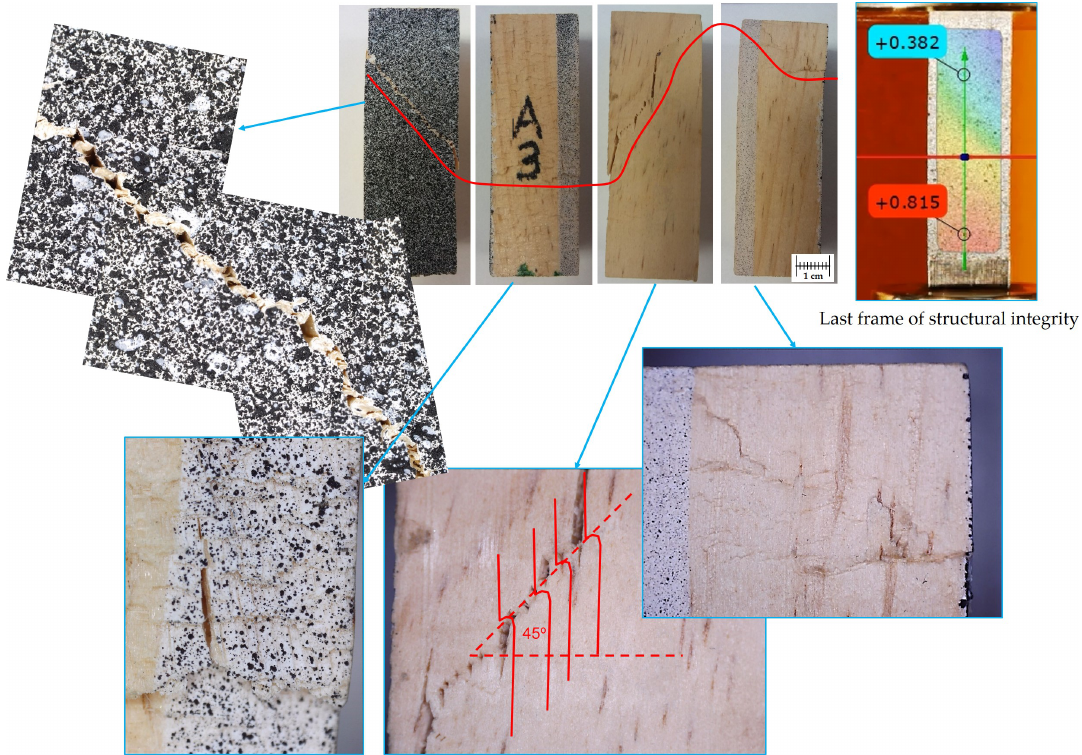
Figure 19. Appearance of the damage produced in the specimen A3. Comparison with the last frame of the structural integrity of the sample.